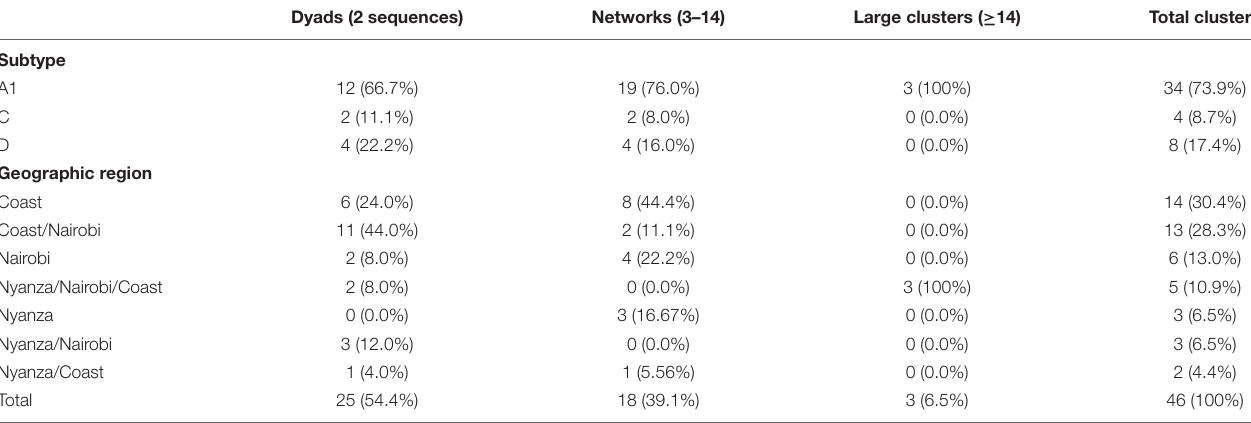
TABLE 2 | The number of Kenyan MSM HIV-1 clusters by cluster size and geographic region. Dyads (2 sequences)